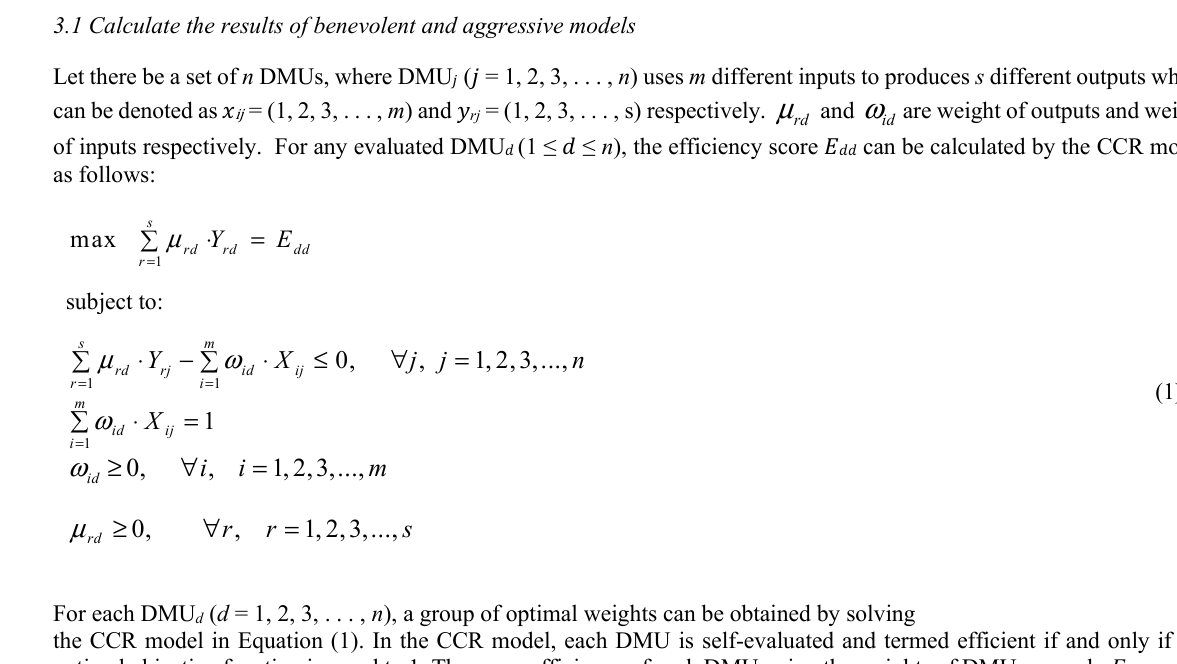
Fig. 1. Diagram for the proposed ranking